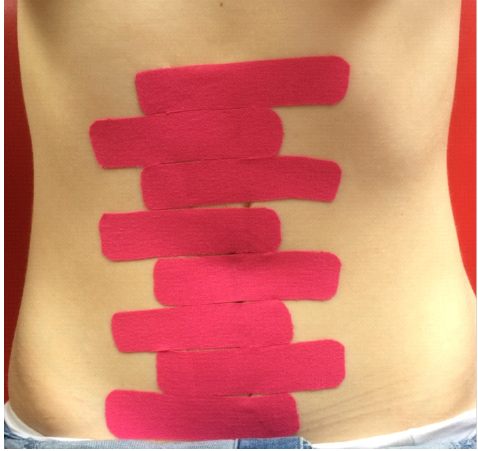
Figure 1. sEMG electrodes placement.